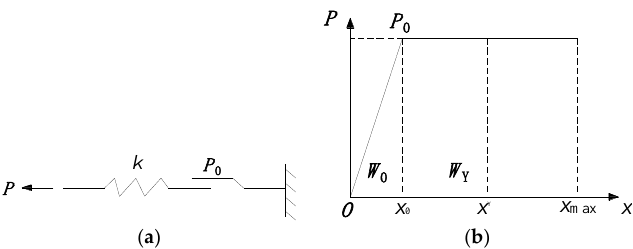
Figure 4 . Principle of the constant resistance anchor cable: ( a ) Before deformation of surrounding rock; ( b ) Under deformation of surrounding rock; ( c ) After deformation of surrounding rock.